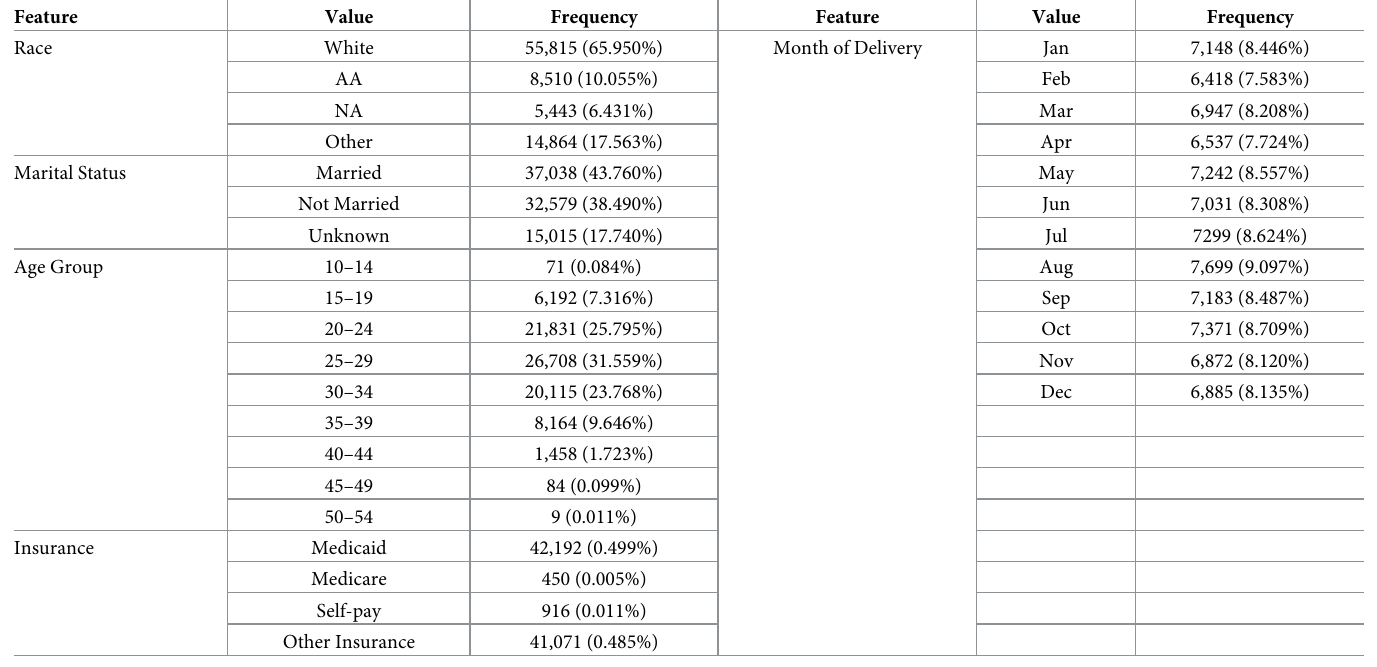
Table 6. Patient demographic attributes in the Oklahoma PUDF, where AA: African American, NA: Native America.